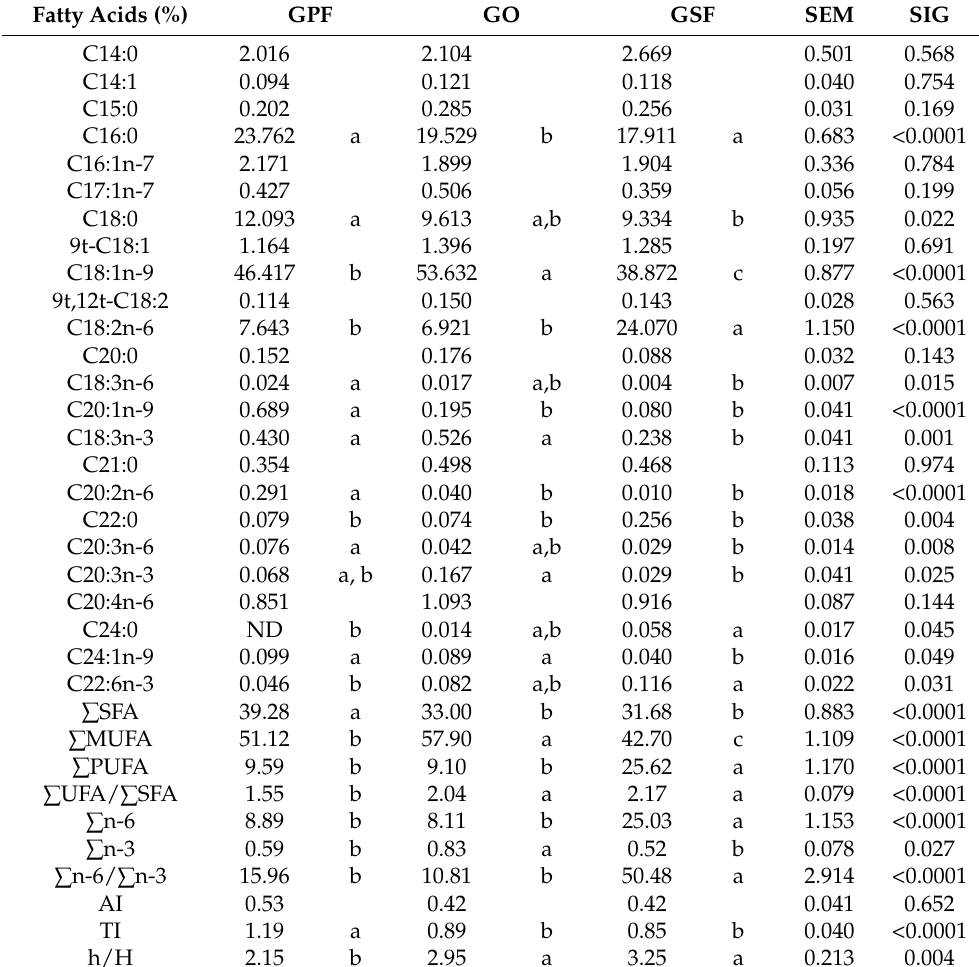
Table 3. Lipidic profile of goat meat burgers with fat